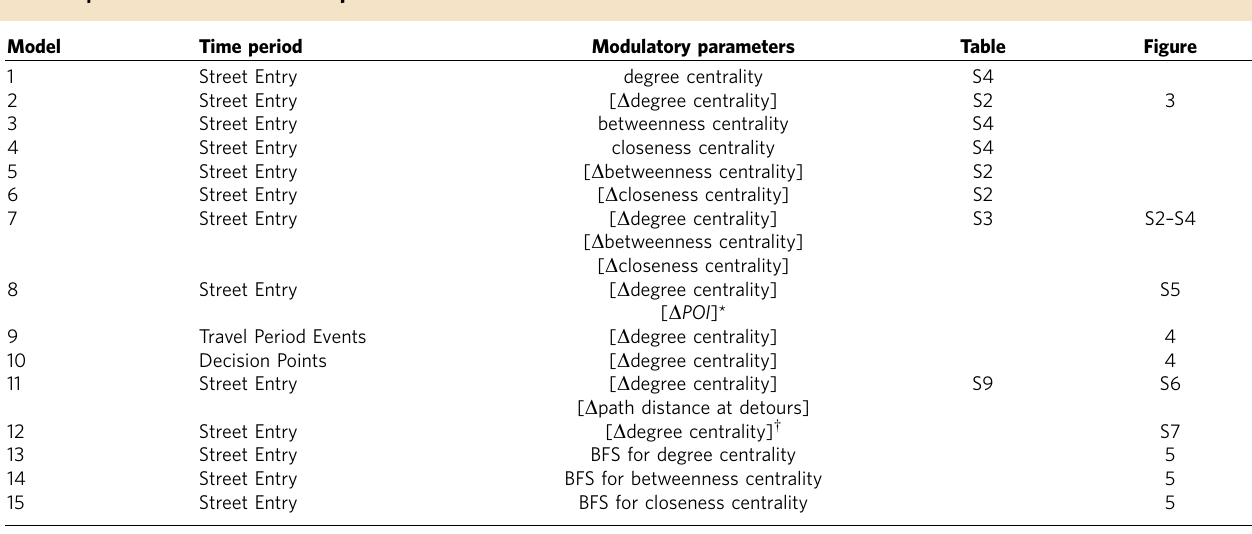
Table 2 | General linear models reported in this